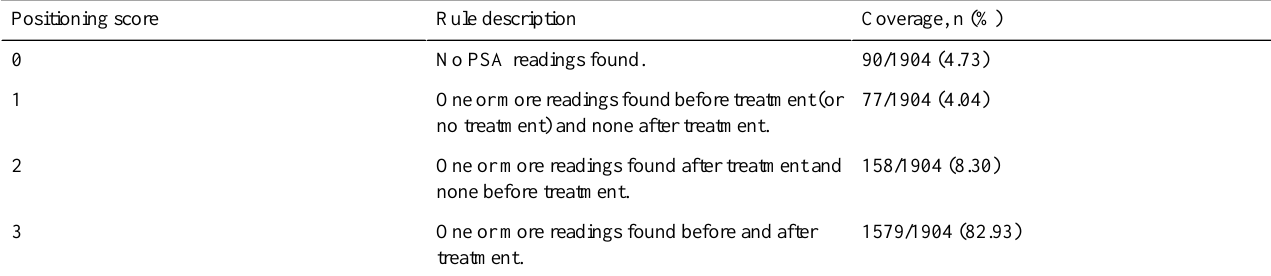
Table 3. PSA availability and positioning rules with respective scores and